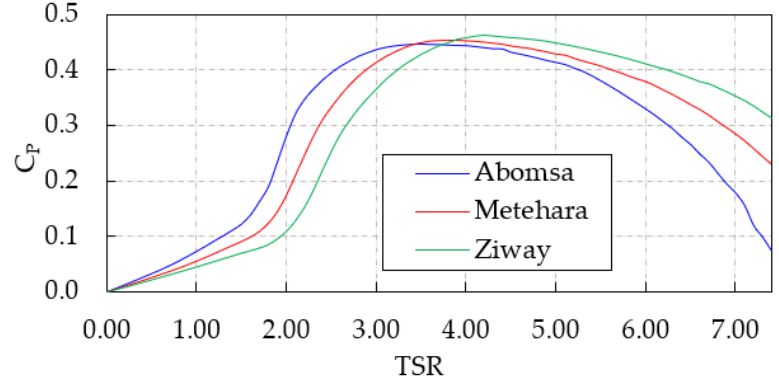
Figure 13. Curve of C P,i vs. λ i of rotor blades for three selected sites.